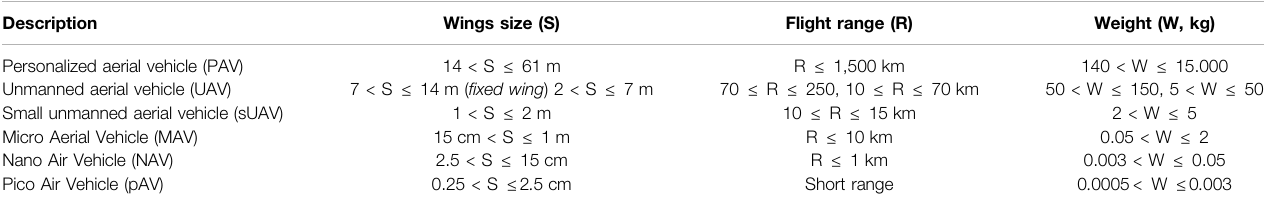
TABLE 3 | Classi fi cation of various types of aerial